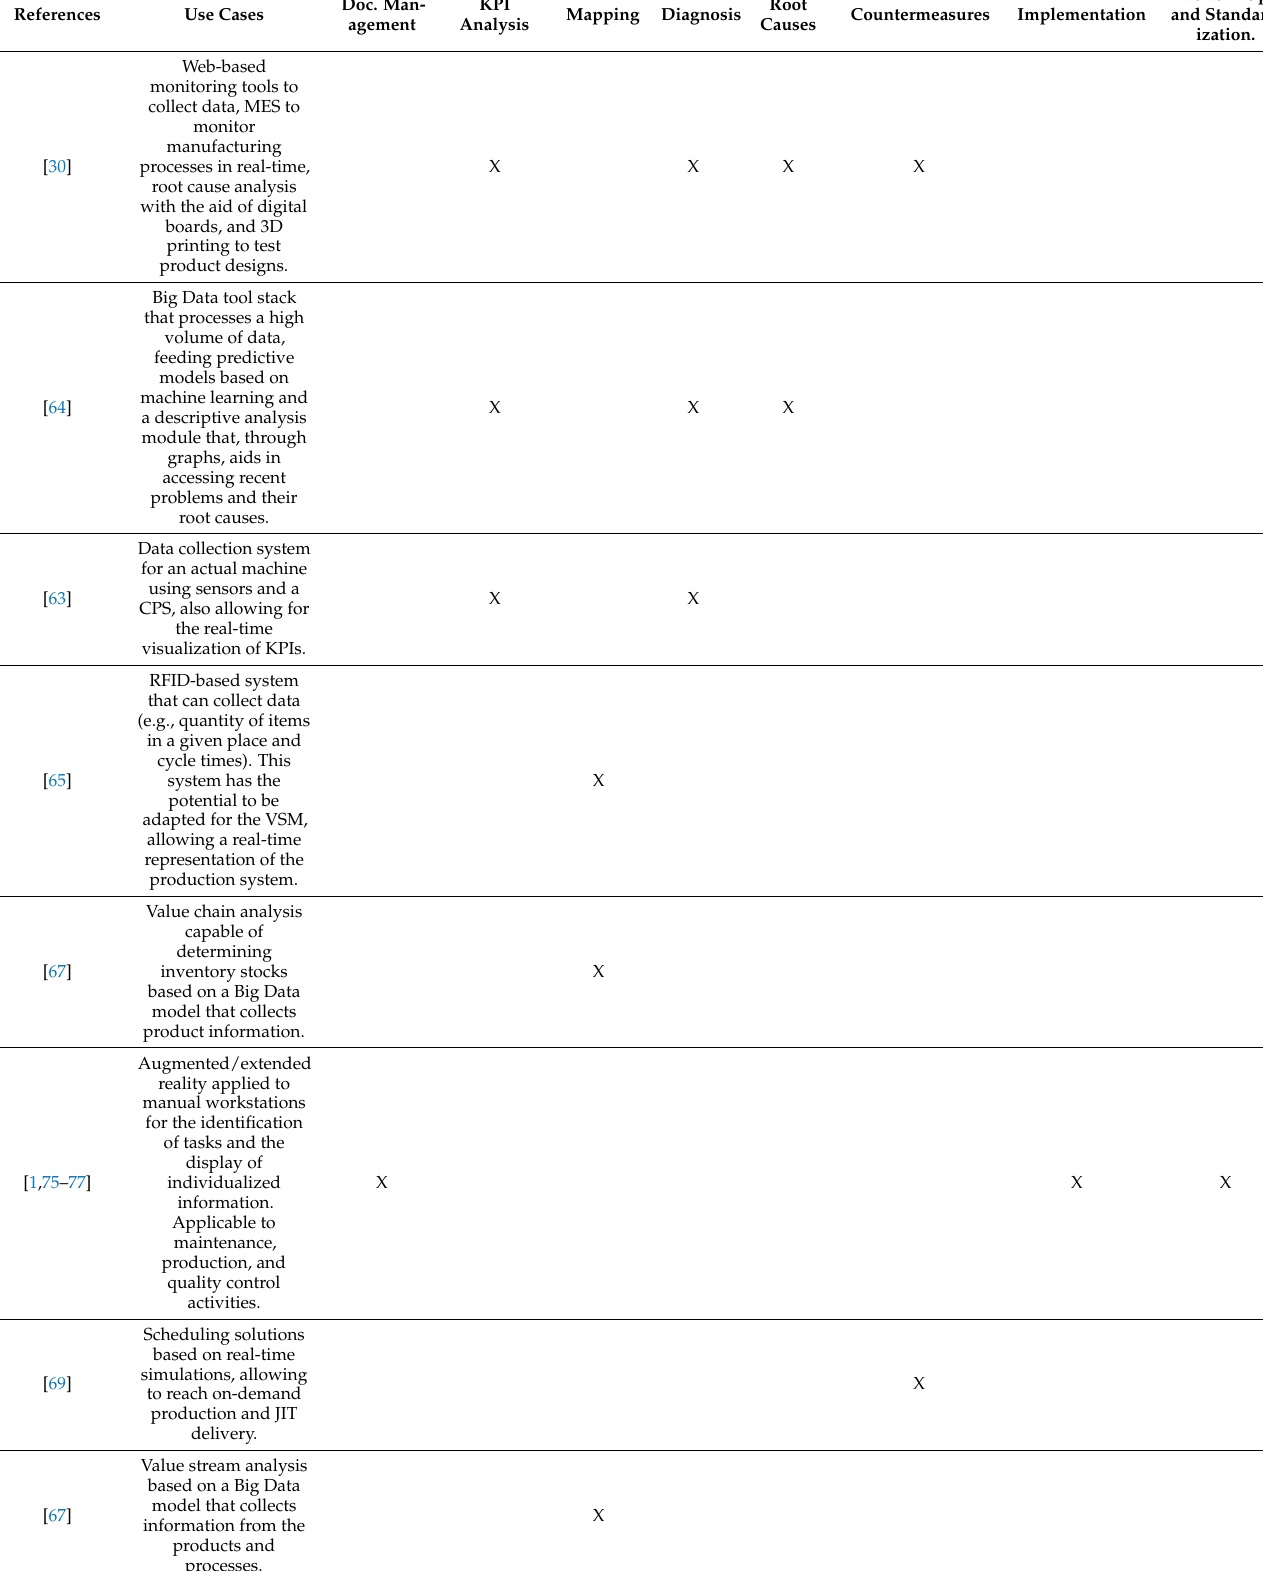
Table A4. Practical approaches for the application of I4.0 to